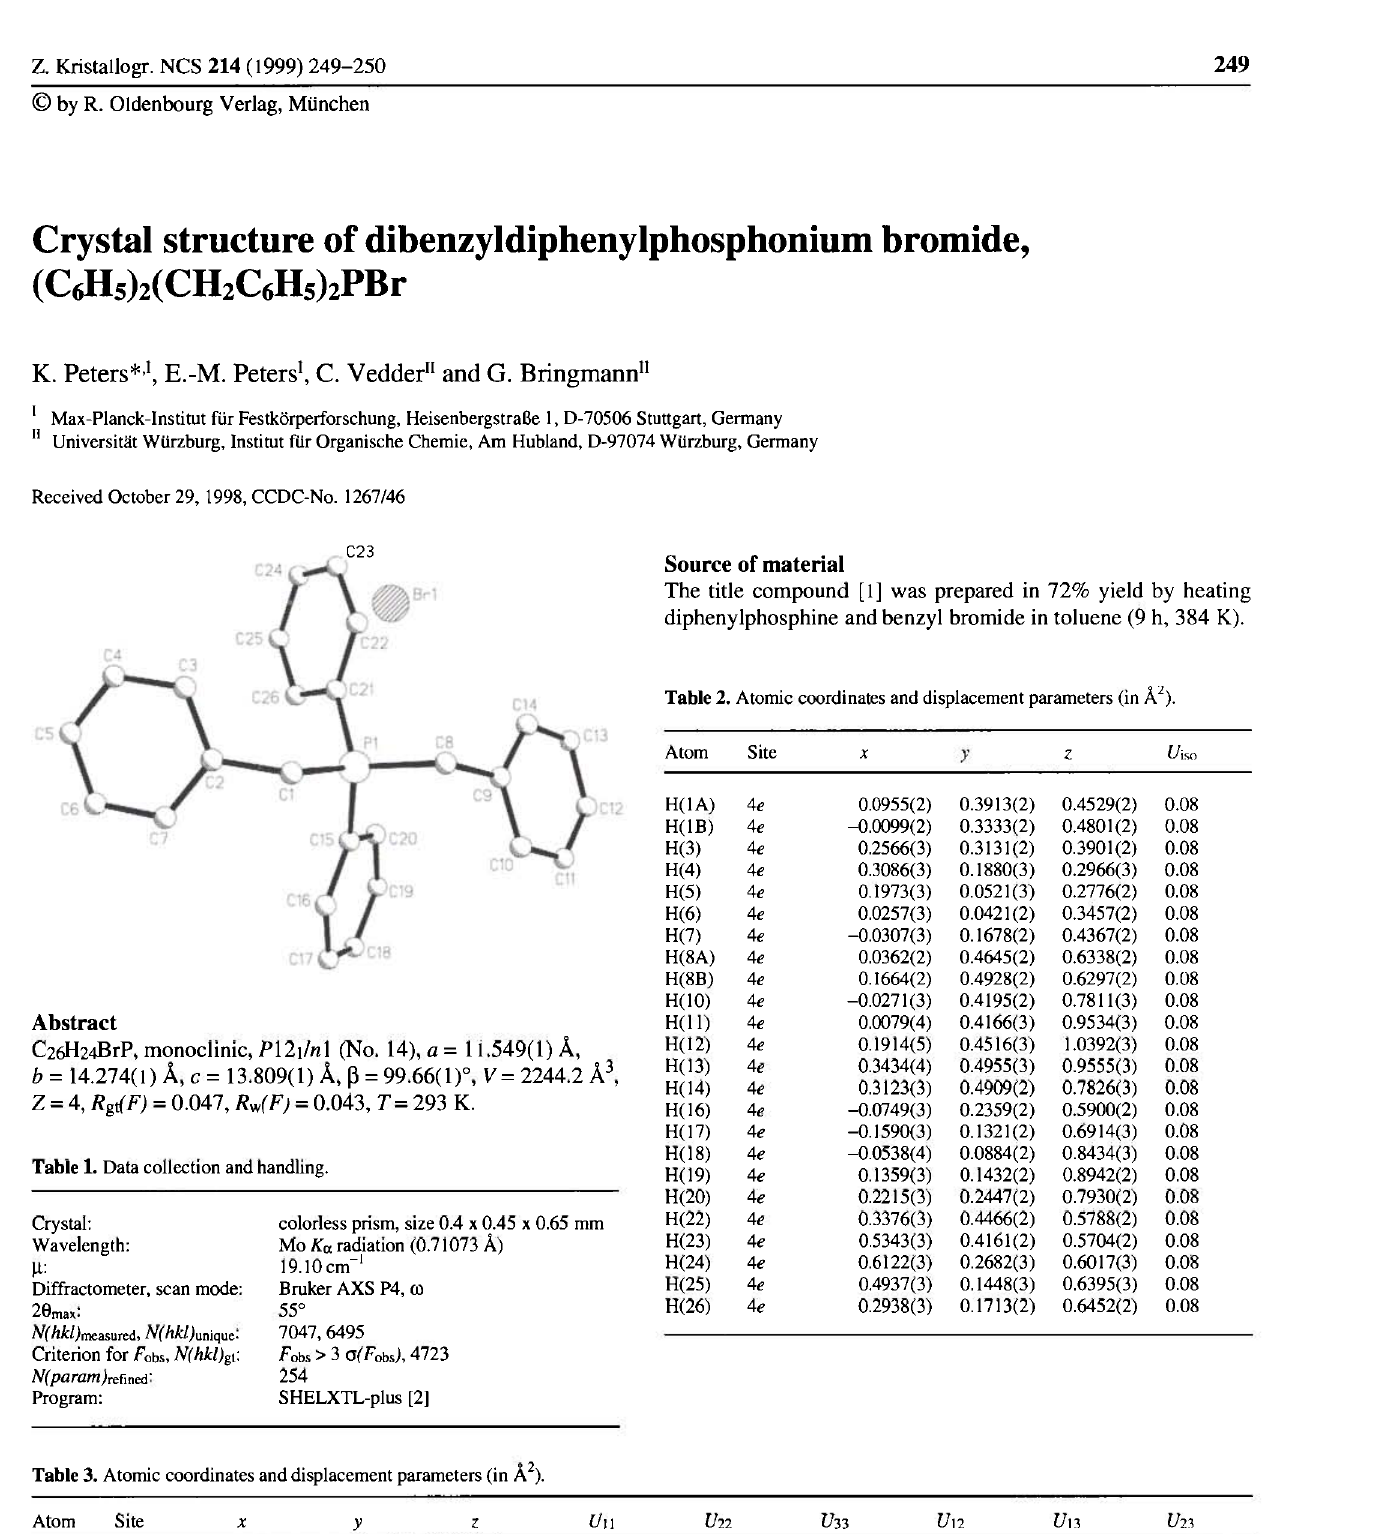
Table 3. Atomic coordinates and displacement parameters (in Ä 2